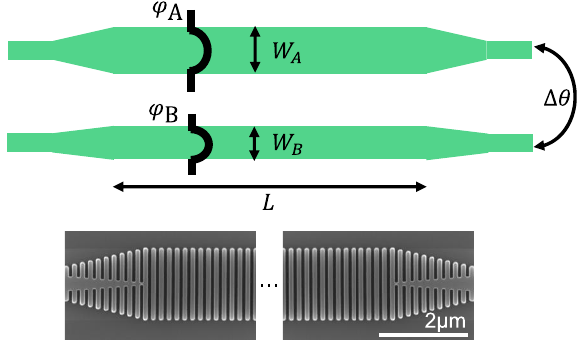
Figure 10: (a) Conventional phase shifters use waveguides of different widths to achieve a controlled phase shift Δ θ between them. When these waveguides are substituted by subwavelength structures the operational bandwidth of the phase shifter can be extended by a factor of